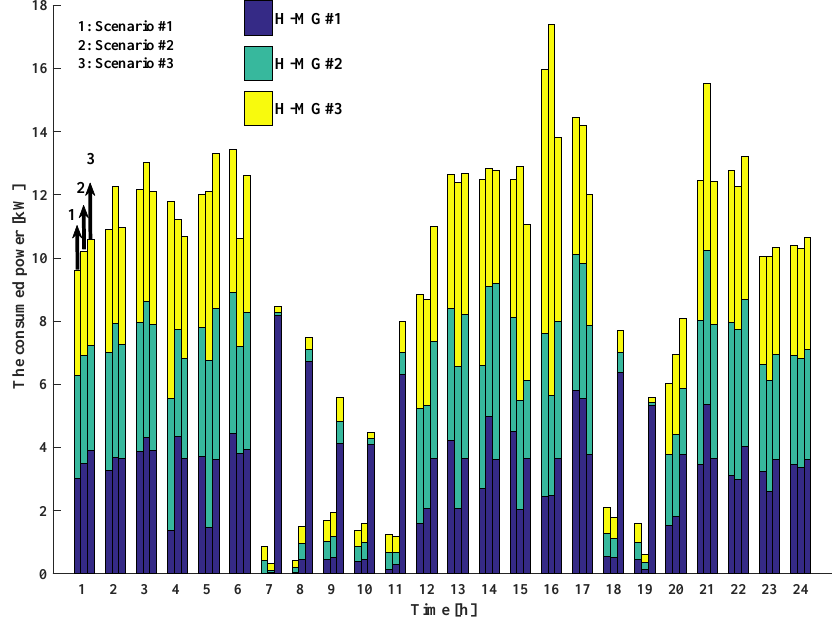
Figure 10. RLD power profile of each